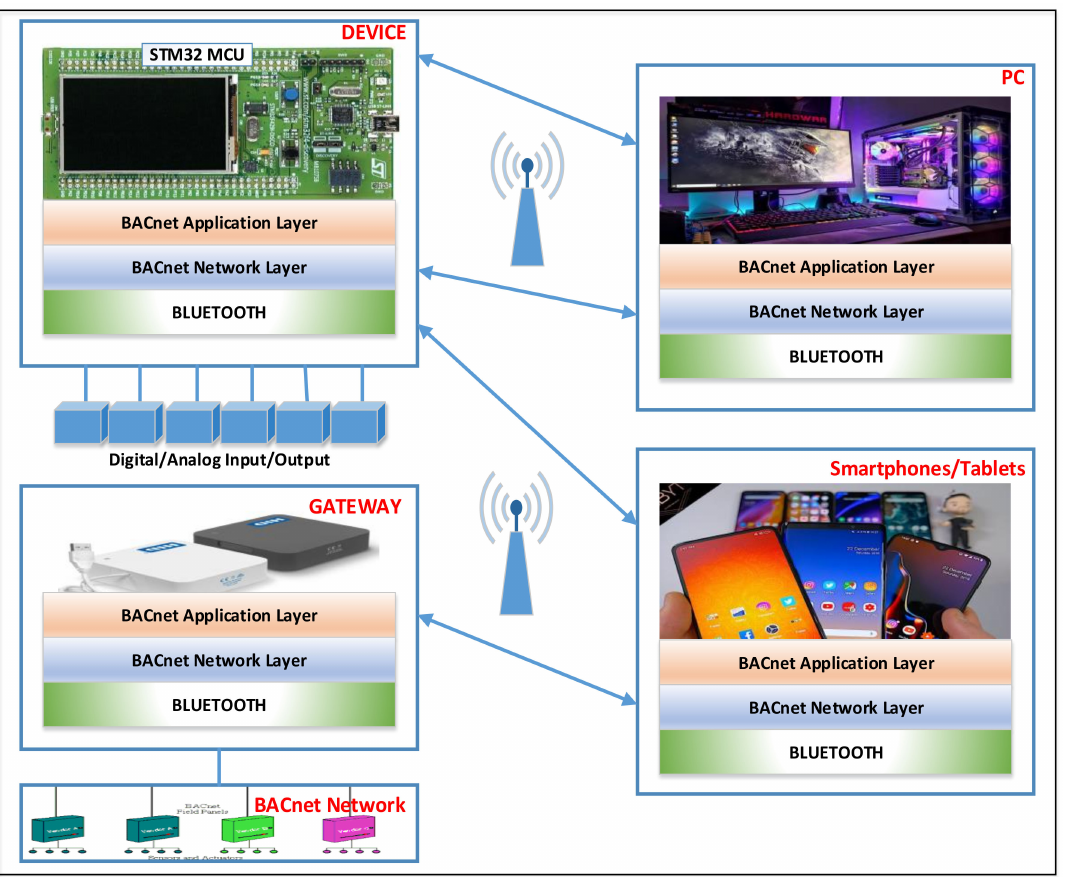
Figure 2. The proposed concept for the implementation of the BACnet Application Layer over